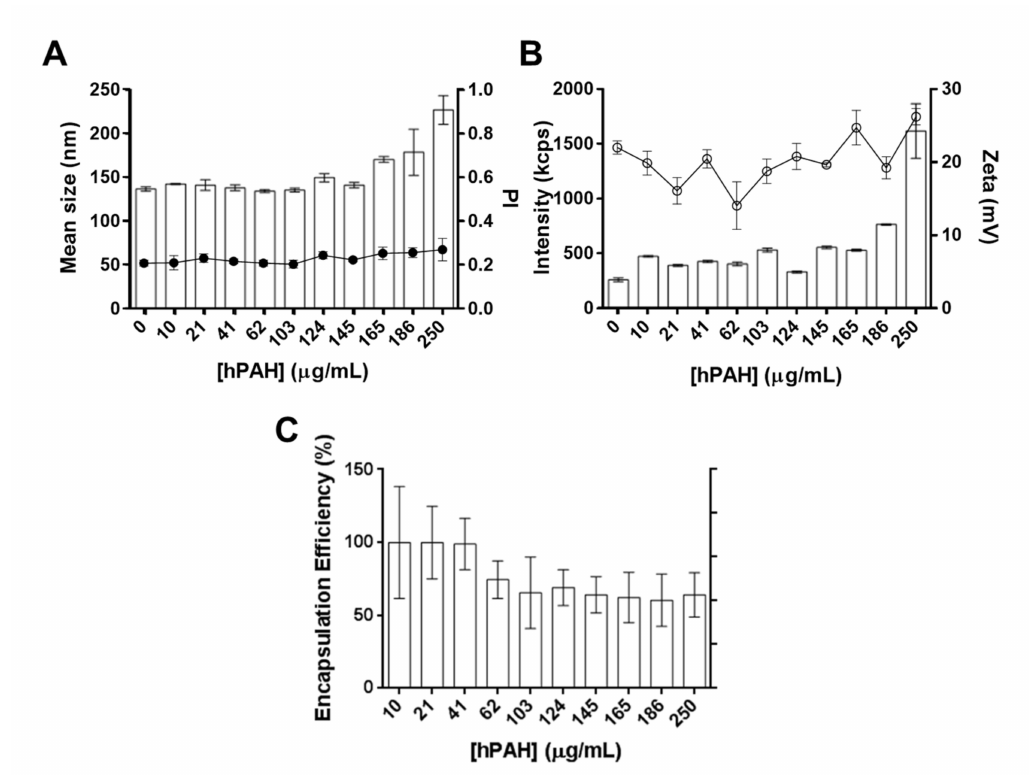
Figure 5. Effect of human phenylalanine hydroxylase (hPAH) loading on the characteristics of optimized nanoparticles (5:1; CS:TPP weight ratio). ( A ) Mean size (bars) and PI (lines) monitored by dynamic light scattering (DLS). ( B ) Nanoparticle yield by intensity of diffracted light (bars) and zeta potential (lines) by DLS. ( C ) hPAH encapsulation efficiency monitored by BCA protein assay; a non-parametrical analysis was performed as referred in Section 2.11 (Controls and Statistical Analysis). Values represent mean ± S.D ( n = 3). For further details see Materials and